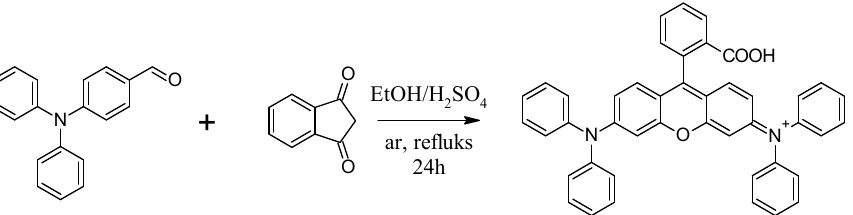
Figure 1. Synthesis of [9-(2-carboxyphenyl)-6-diphenylamine-3-xanthenylidene]-diethylammonium chloride–rhodamine B derivative.